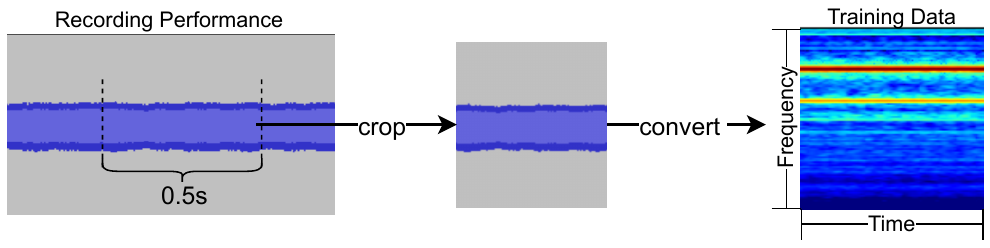
Figure 6. Data creation